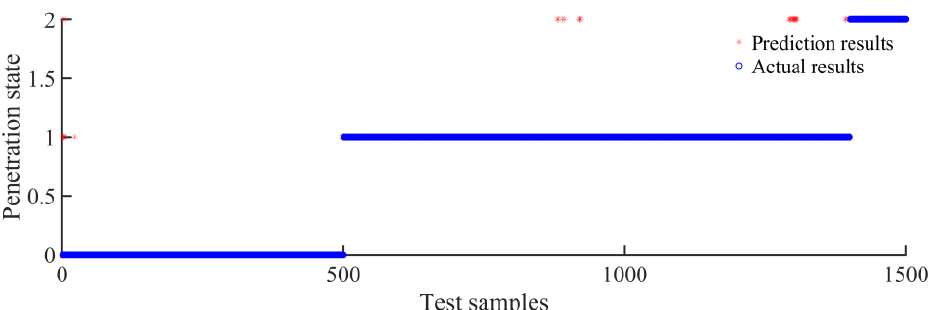
Figure 12. Recognition results of the penetration state by using another training method of recognition model.